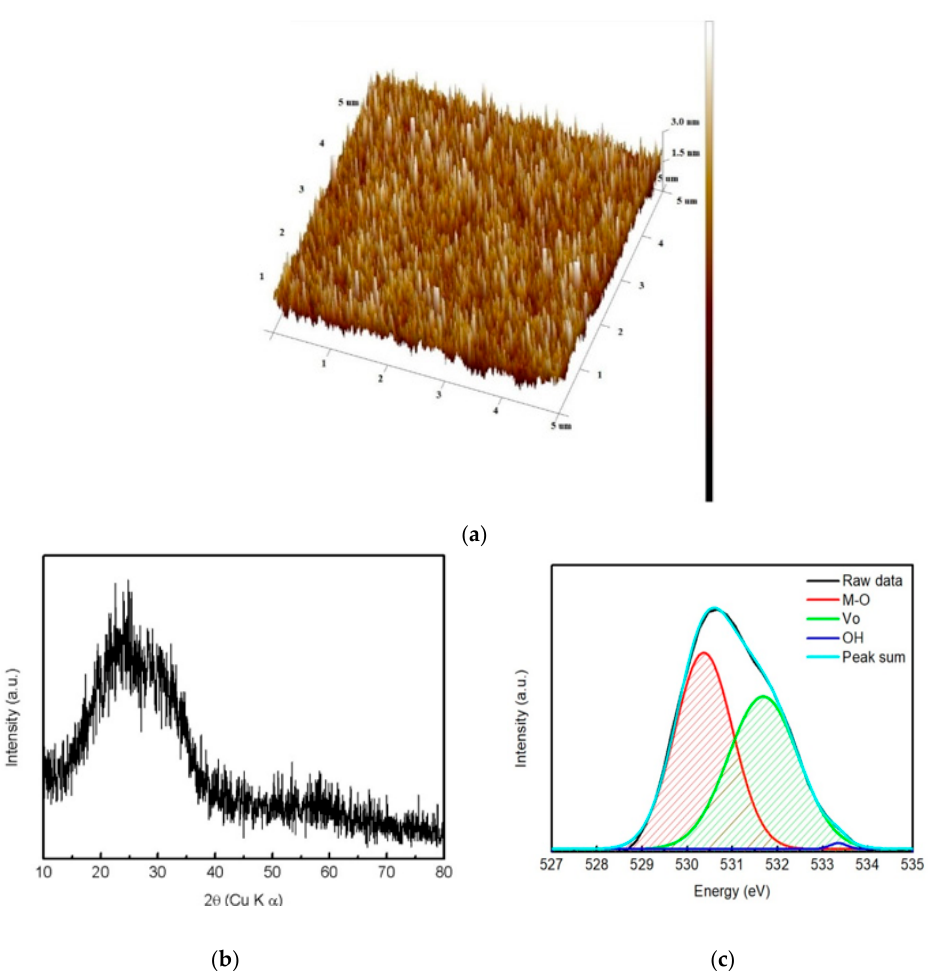
Figure 2. ( a ) AFM result of the sputtered IGO thin film. ( b ) XRD result of the sputtered IGO thin film. ( c ) XPS result of the sputtered IGO thin film.